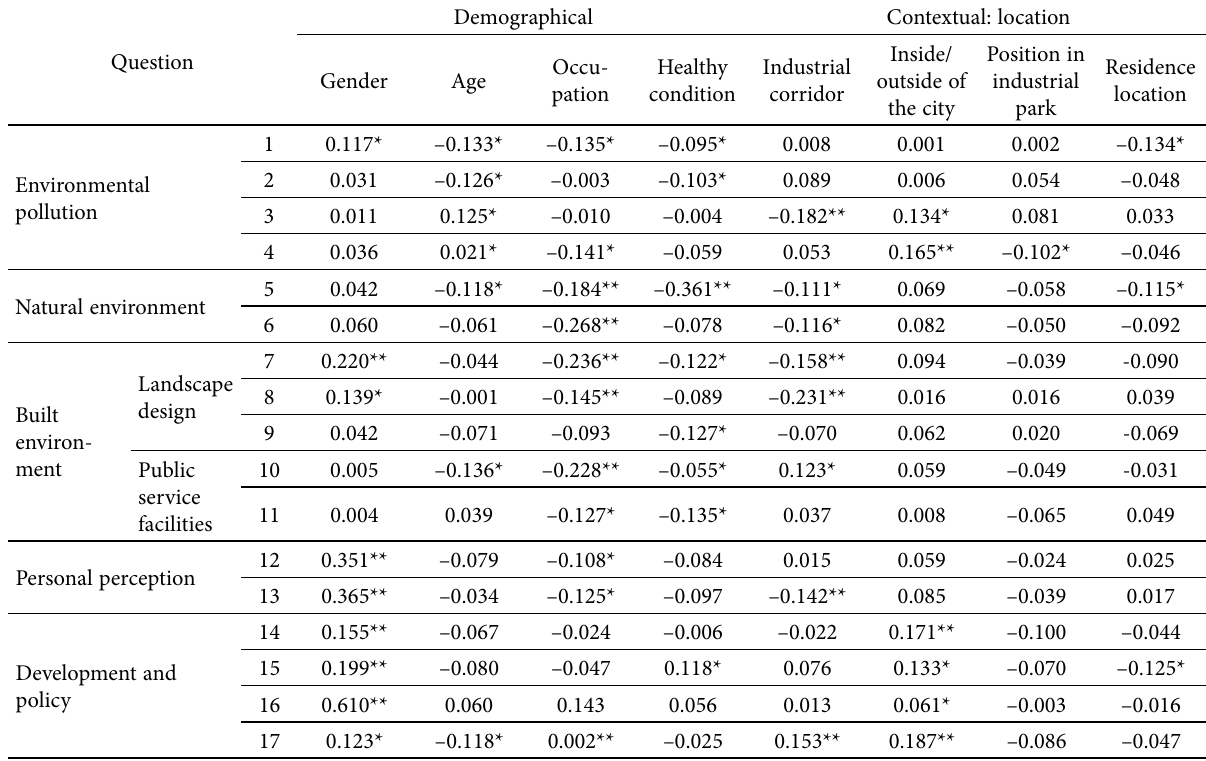
Table 5. Spearman correlation coefficients among demographical/contextual factors considering location and people’s subjective evaluation, with significance levels (2–tailed); mean differences in terms of the subjective evaluation between males and females and between residents inside/outside the city, with significance levels (t–test, 2–tailed). Digital codes are shown in Table 2 and Table